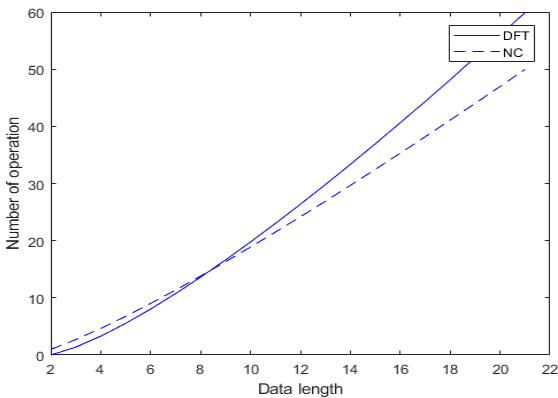
Figure 13. The growth of computational complexity with a change in the number of incoming samples.